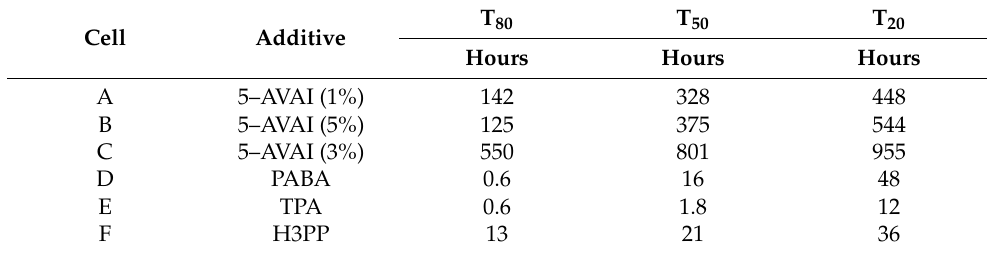
Table 2. Lifetime parameters extracted from degradation trends shown in Figure 4. T X is the time at which power conversion efficiency is X% of the initial nominal power conversion